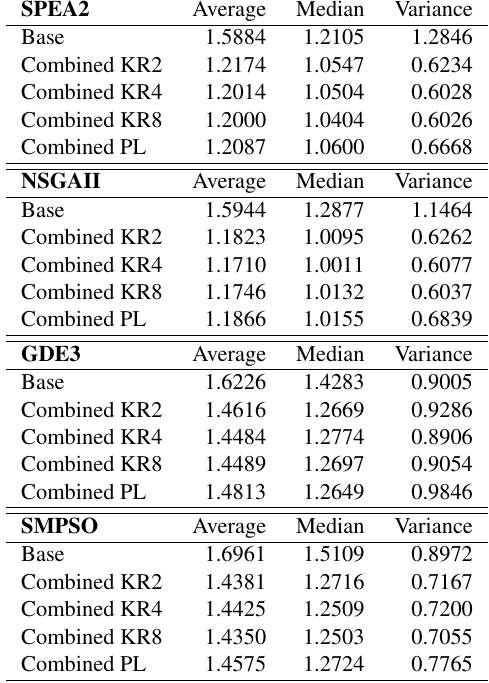
Table 4. ER - Extreme Risk metric.